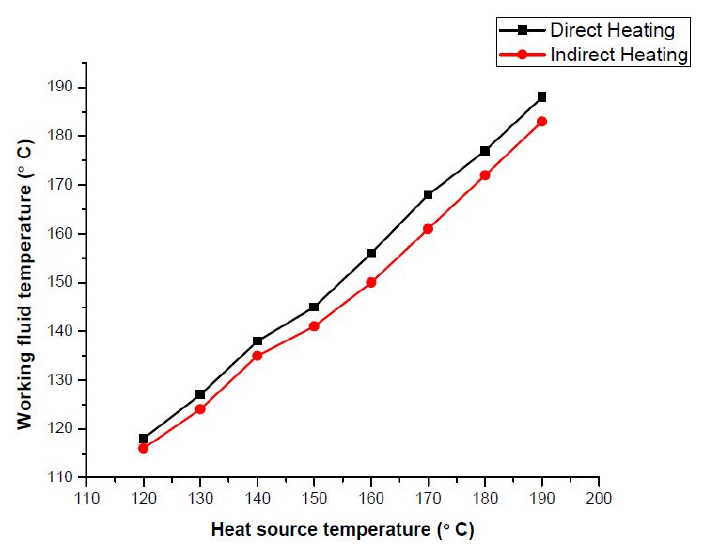
Figure 4. Variation of working fluid temperature with heat source temperature.